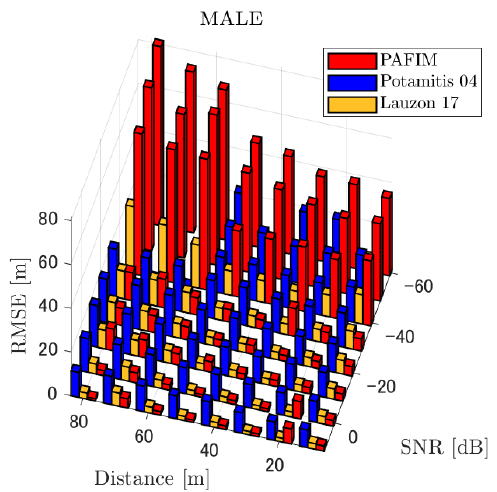
Figure 6. RMSE of tracking a stationary sound source emitting male voice.